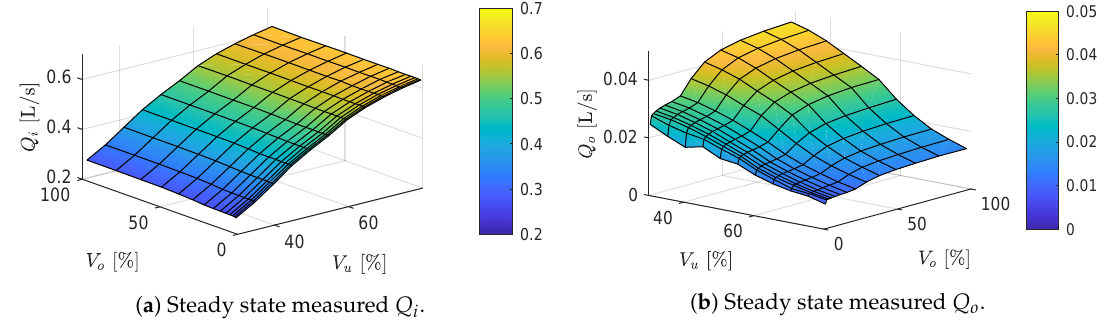
Figure 22. Steady state flow rates as function of valve